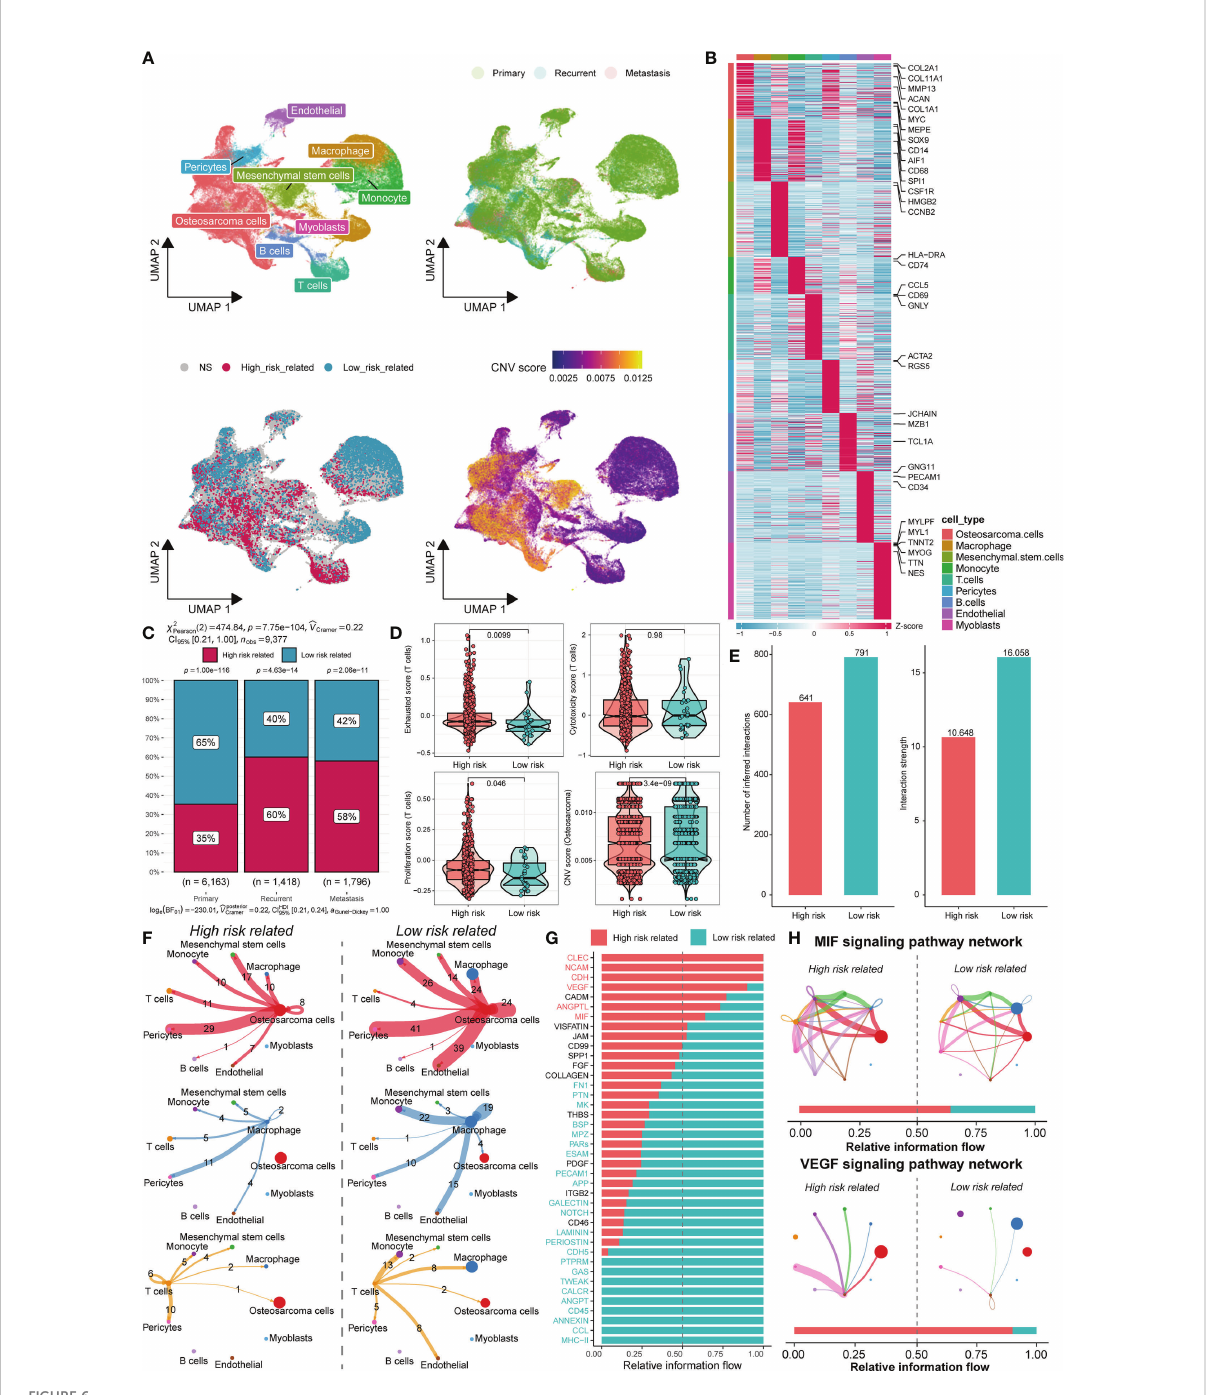
FIGURE 6 TME differences in cells associated with different risk scores. (A) UMAP analysis identi fi ed nine major cell types in osteosarcoma samples (top left), sample groupings involving primary, recurrent, and metastasis (top right), associated cells by SCISSOR risk groupings (bottom left), and CNV score inferred by the infercnv-related heatmap (bottom right). (B) The DEGs and marker genes for nine major cell types are shown. The colors in the top and side bars indicate speci fi c cell clusters. (C) A bar graph depicts the proportion of cells in different sample groupings that are associated with the risk score. (D) Boxplots depict the exhaustion (top left), toxicity (top right), and proliferation (bottom left) scores of T cells in the two risk score groups. The difference in the CNV score between osteosarcoma cells is shown (bottom right). (E) Differences in the number of cells associated with different risk scores and the intensity of their cellular communication. (F) Circos plots depict putative ligand – receptor interactions between T cells from the high-risk (left) and low-risk (right) associated cell groups and other cell clusters. Branches connect pairs of interacting cell types and indicate the number of events in the graph. (G) In the inferred network, the overall information fl ow differences for the different risk-group-associated cells are shown. (H) Circos plots show the MIF signaling pathway and VEGF signaling pathway of related cells in different risk